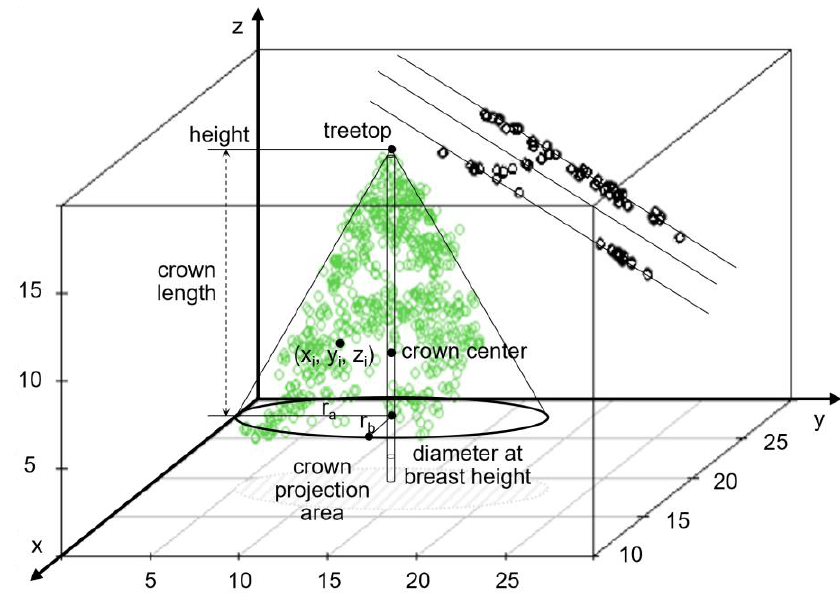
Figure 5. Three-dimensional geometric shape and parameters of the sample tree. Other estimated parameters of the model are as follows: tree height = 19.2 m, crown length = 16.78 m, length of the semi-major axis ( r a ) = 7.89 m, length of the semi-minor axis ( r b ) = 3.55 m, treetop coordinates = (13.73, 17.87, 19.2), crown center coordinates = (13.73, 17.87, 6.62), crown projection area = 88.08 m 2 , D bh = 22.18 cm, mean height of wires = 14.61 m, wire center coordinates = (25.34, 20.83,